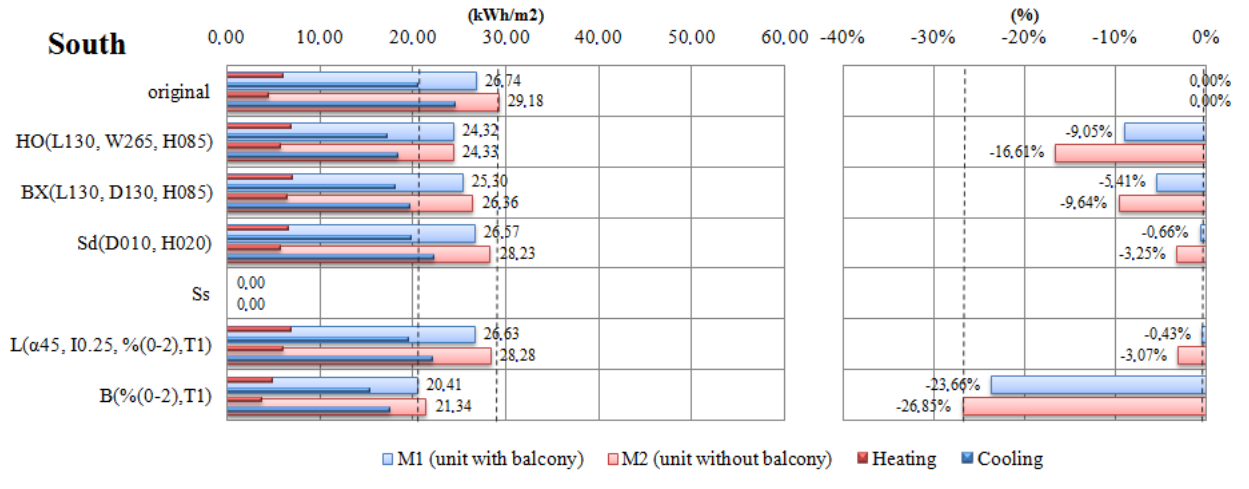
Figure 8. Annual thermal demand (South).